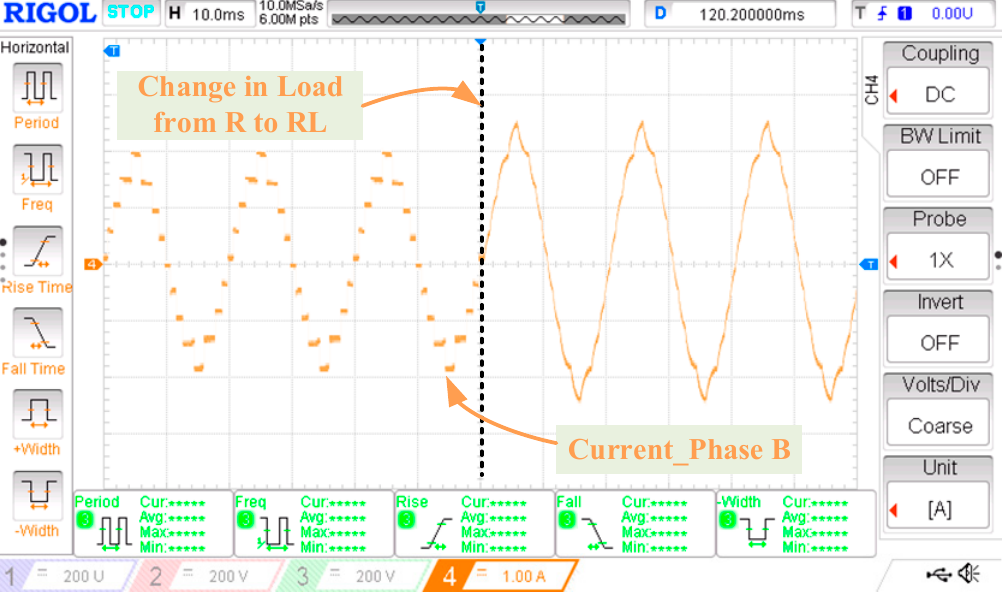
Figure 18. HIL result: phase B current when load changes from R to RL.